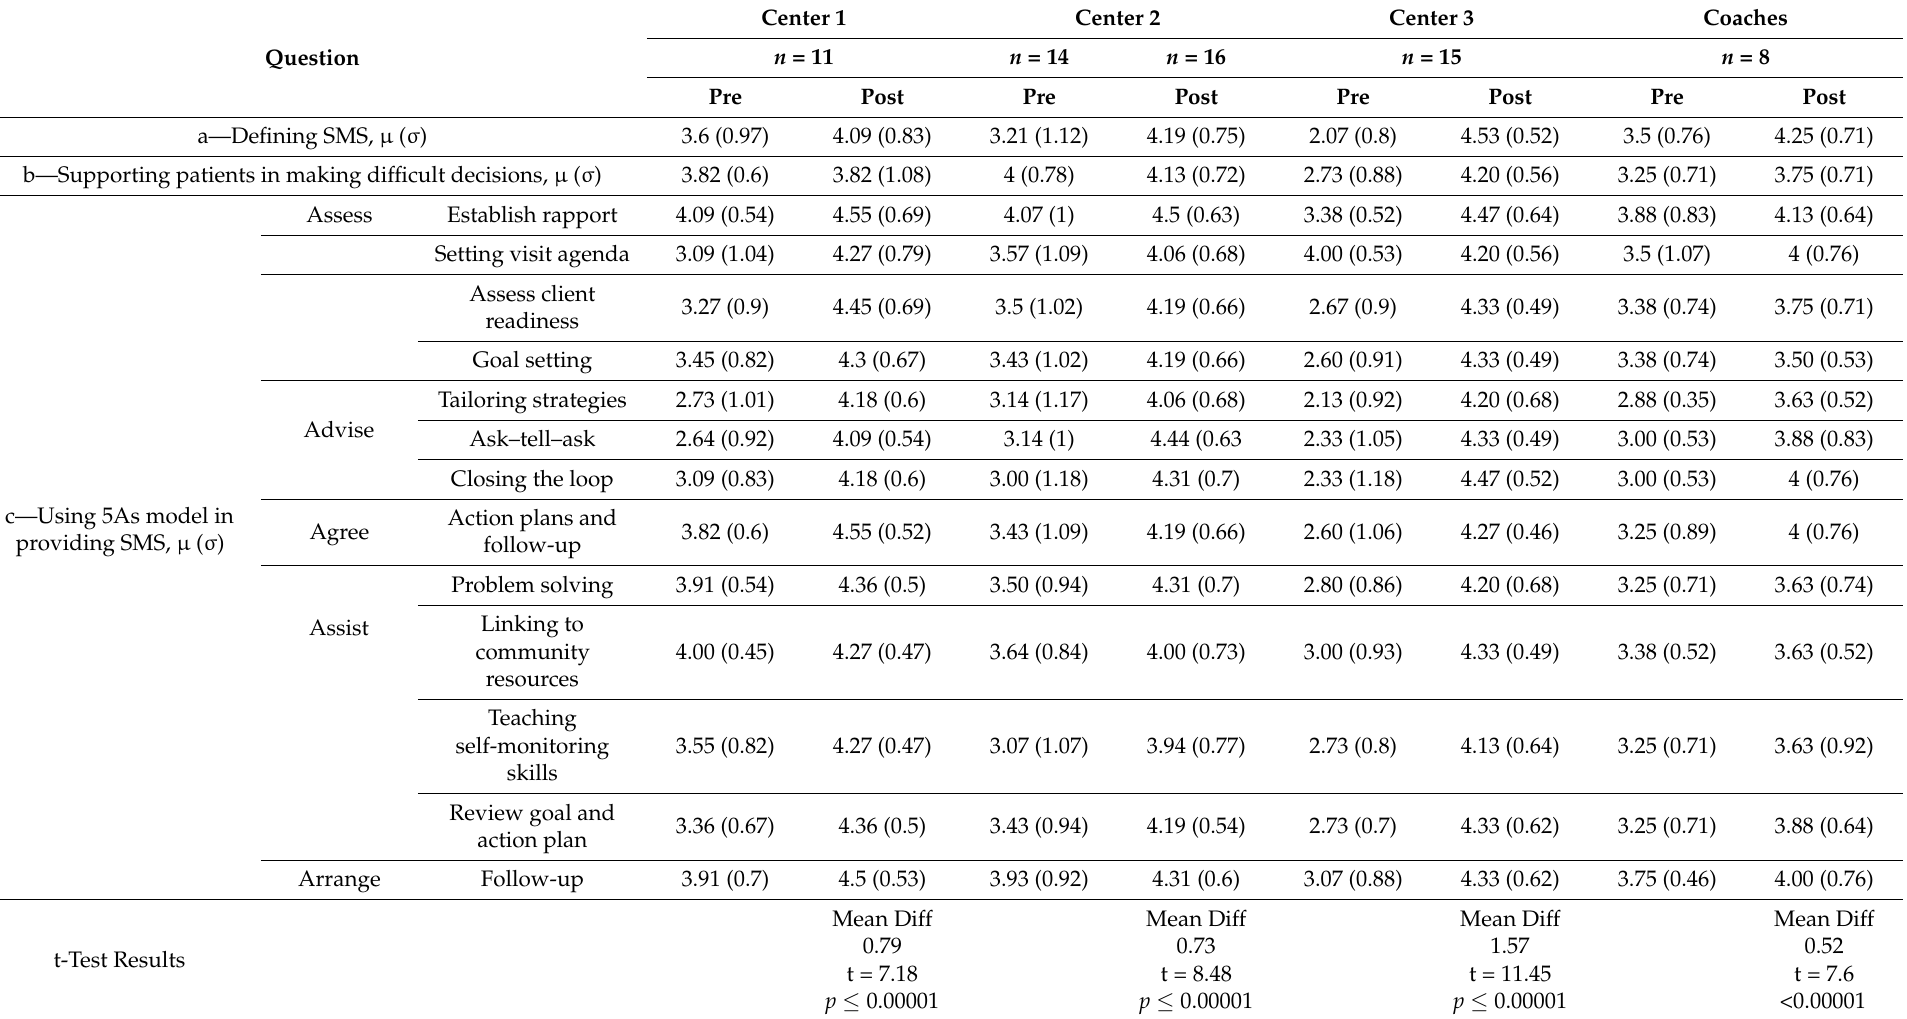
Table 3. Mean scores for pre/postsurvey confidence in self-management support skills by center and for